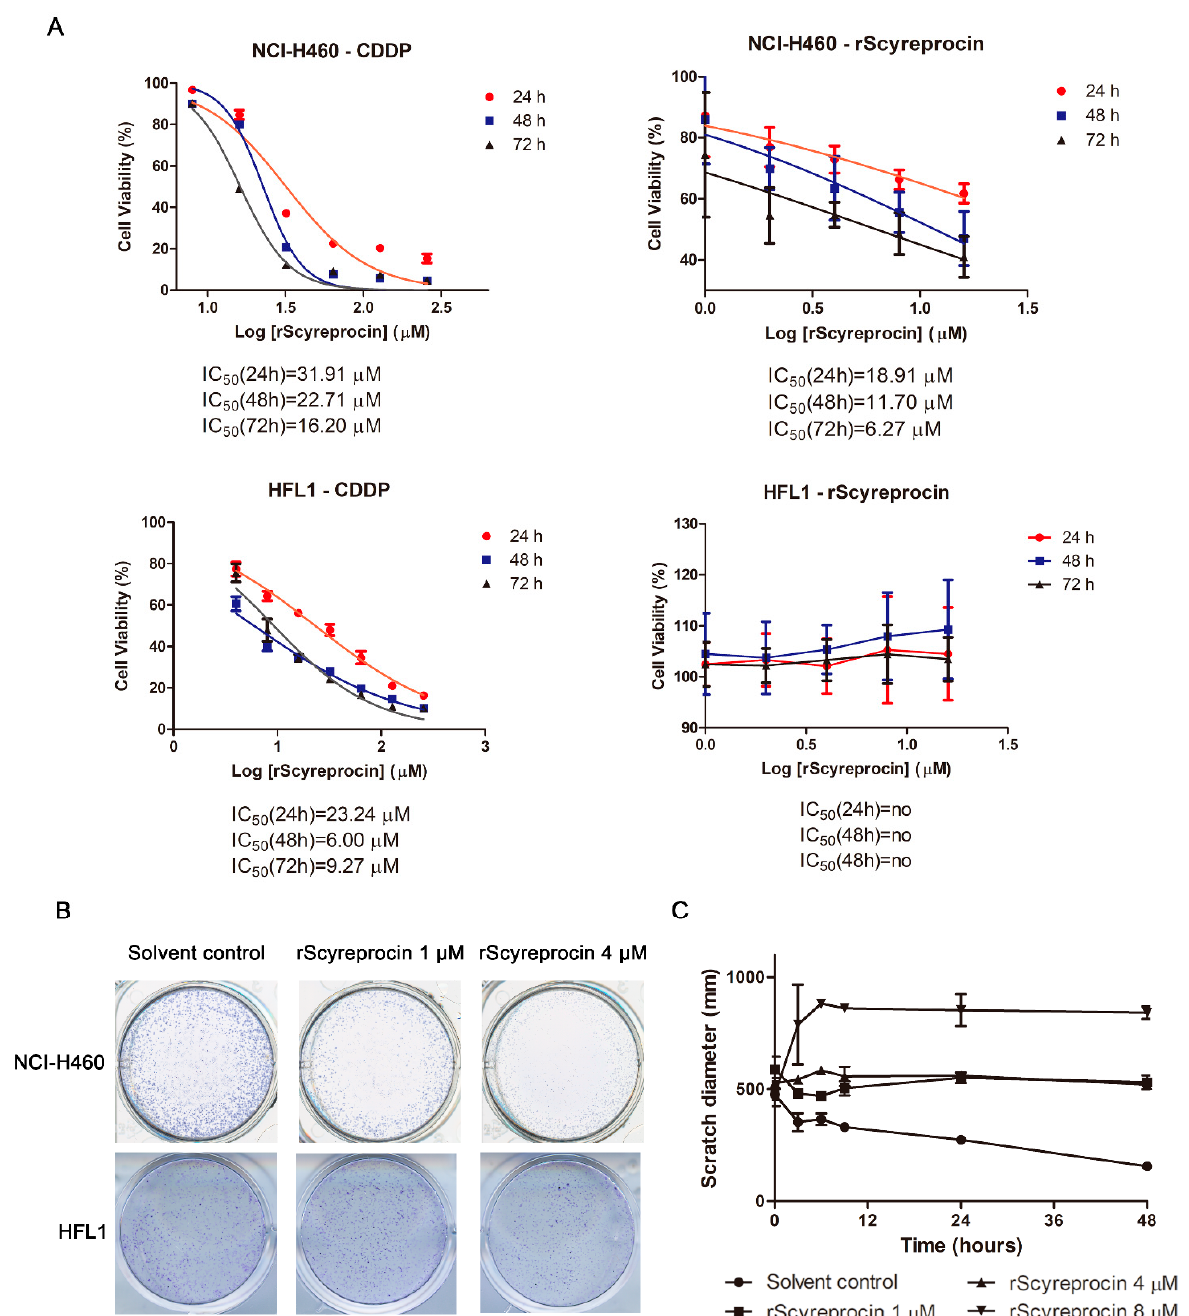
Figure 2. Recombinant scyreprocin (rScyreprocin) inhibited proliferation of H460 cells but not HFL1 cells. ( A ) Effects of rScyreprocin on H460 and HFL1 cell viability. Cells were incubated with various concentrations of rScyreprocin or CDDP; cell viability was determined by MTS method at different time points ( n = 3). ( B ) Effect of rScyreprocin of H460 and HFL1 colony formation ability. Cells were treated with rScyreprocin for 48 h and cultured in rScyreprocin-free medium for another 12 days. Samples were fixed and stained with crystal violet before microscopic examination. ( C ) Inhibitory effect of rScyreprocin on H460 cell migration. Scratches of H460 were treated with various concentrations of rScyreprocin; the shortest distances between the edges were measured and analyzed at different time points ( n = 3). Data in ( A , C ) are presented in means ± standard deviations (SD).